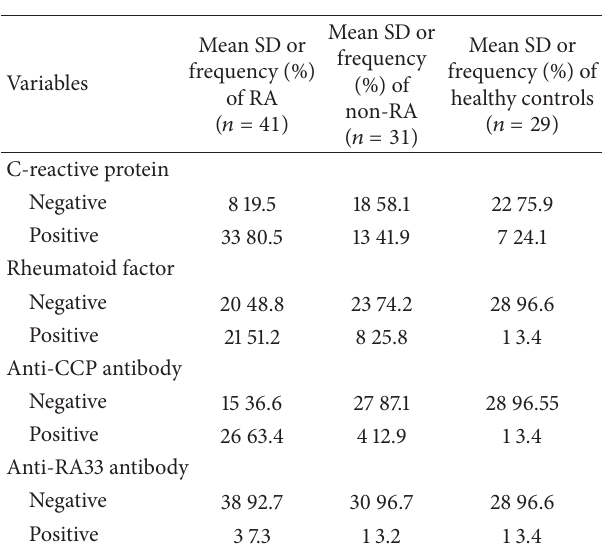
Table 2: Diagnostic immunology markers in RA and non-RA pati- ents and healthy controls.